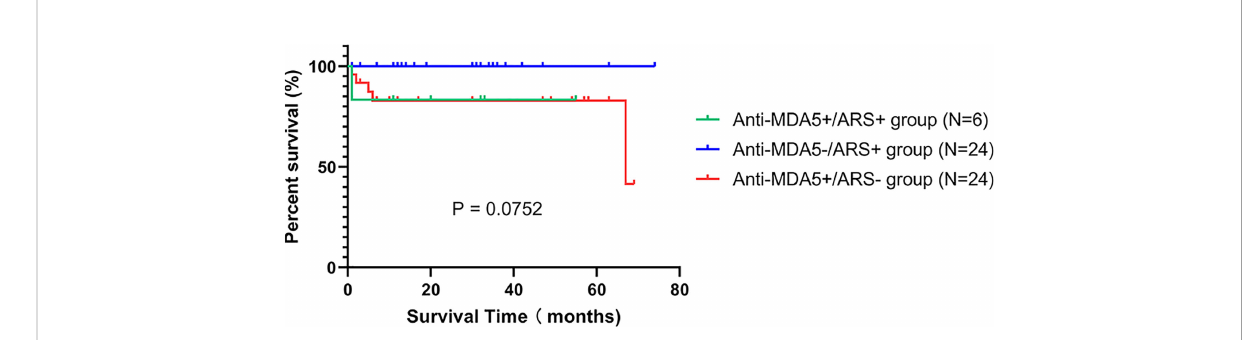
FIGURE 2 Kaplan-Meier curves for the anti-MDA5+/ARS+, anti-MDA5-/ARS+, and anti-MDA5+/ARS- subgroups.